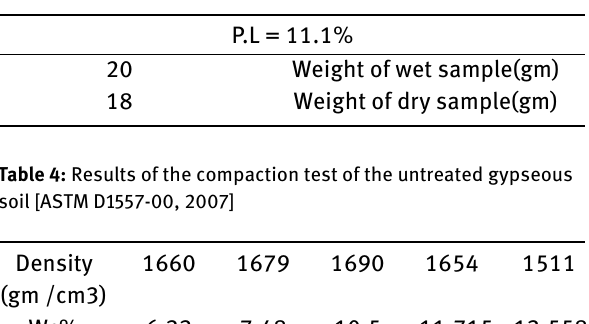
Table 3: Results of the plastic limit test of the untreated gypseous soil [ASTM D4254-2000]